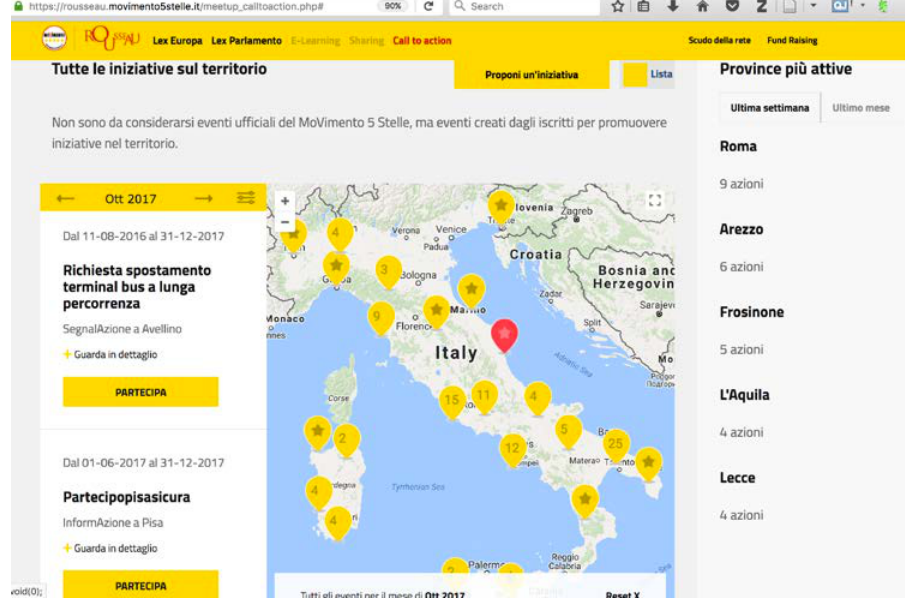
Figure 1: The Call to Action area of Rousseau (source: